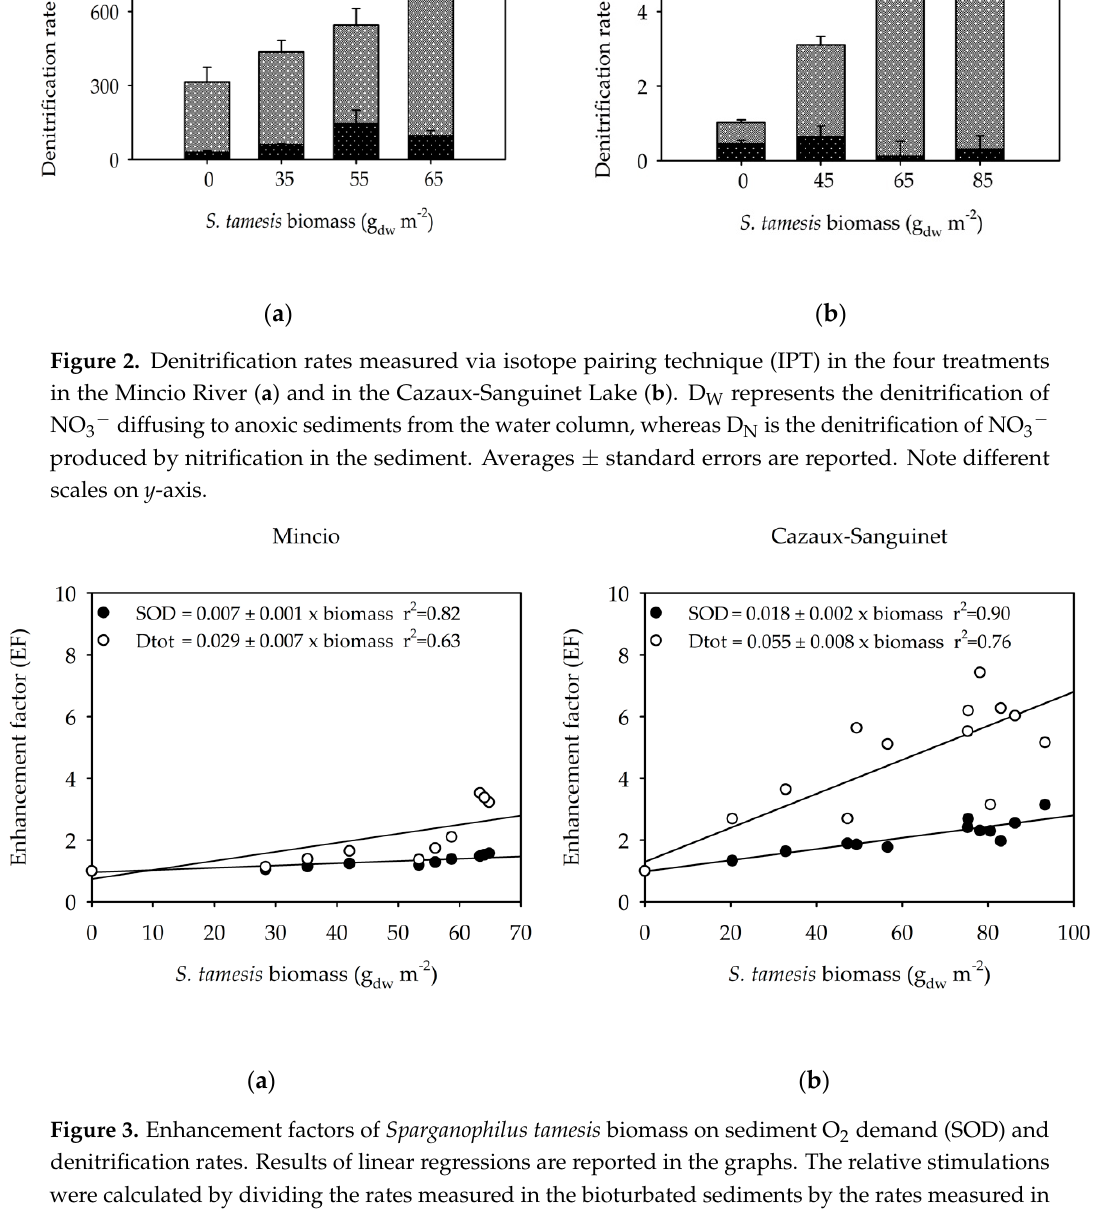
Figure 2. Denitrification rates measured via isotope pairing technique (IPT) in the four treatments in the Mincio River ( a ) and in the Cazaux-Sanguinet Lake ( b ). D W represents the denitrification of NO 3 − diffusing to anoxic sediments from the water column, whereas D N is the denitrification of NO 3 − produced by nitrification in the sediment. Averages ± standard errors are reported. Note different scales on y -axis.